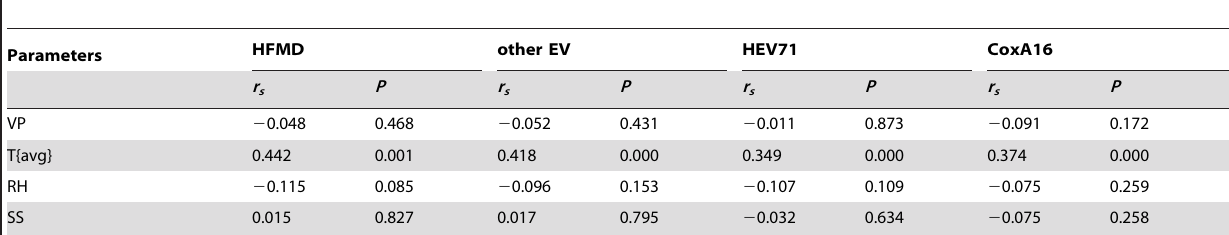
Table 3. Partial correlations between meteorological parameters and hospitalizations of children with HFMD for the adjustment of correlations among other meteorological parameters.